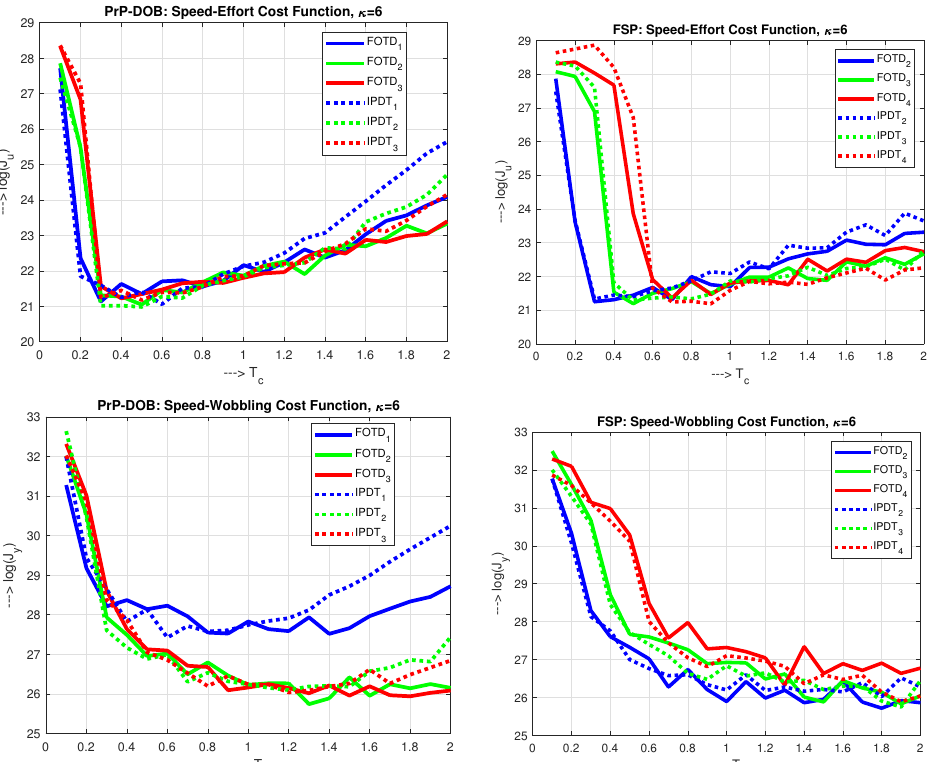
Figure 16. PrP-DOB controller (Equation (26)) combined with filtration according to Figure 1 and Figure 5, λ = − n / T c ( left ) and FSP controller (Equations (39)–(52)) ( right ). Speed-effort ( above ) and speed-wobbling cost functions (B) versus the tuning parameter T c ∈ [ 0.1,2 ] s; κ =